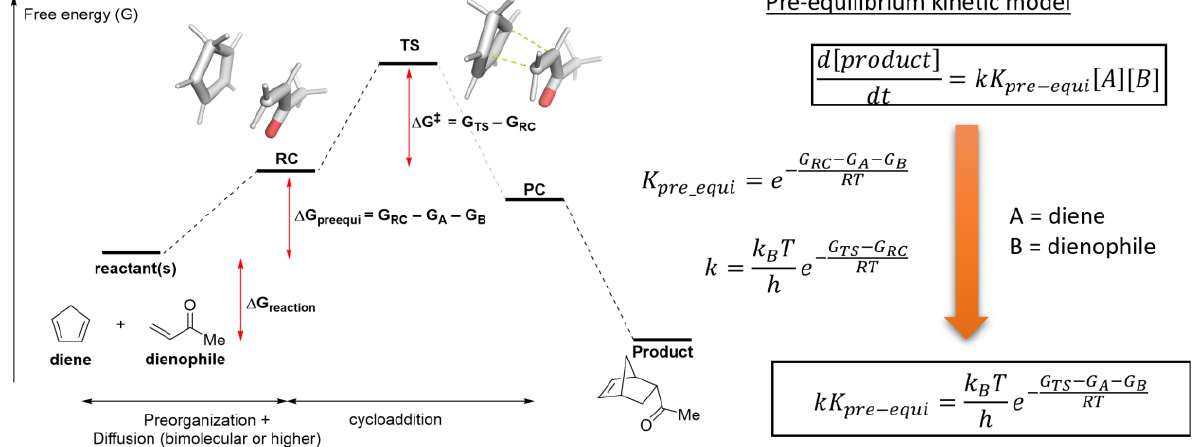
Figure 5. The reaction profile of a [4 + 2] cycloaddition. RC: Reactant Complex. PC: Product Complex. G is the free energy of the species labeled in the subscript. Reprinted with permission from ref [92]. Copyright 2016 American Chemical Society.